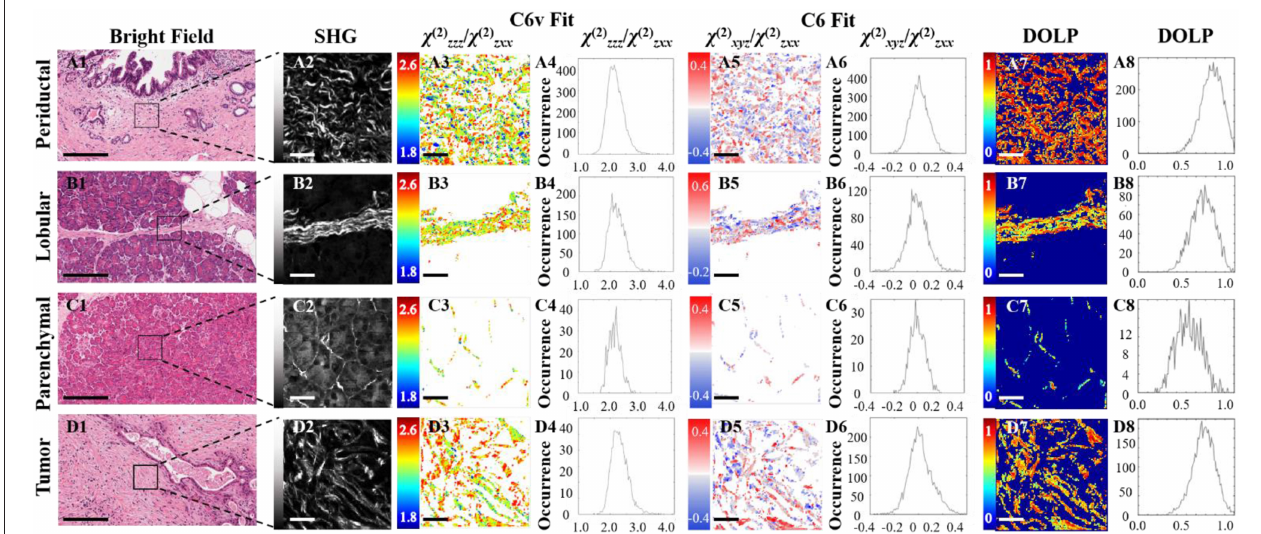
FIGURE 3 | PIPO SHG of collagen in normal periductal (A) , lobular (B) and parenchymal (C) pancreas tissues, and in pancreatic cancer (D) . Bright-field images (A1,B1,C1,D1) where the scale bar represents 200 µ m, and the corresponding SHG intensity images (A2,B2,C2,D2) of the regions of interest are shown, together with color-coded maps of the fitted R values (A3,B3,C3,D3) assuming C 6v symmetry and the occurrence histograms of the R values (A4,B4,C4,D4) where the scale bar represents 25 µ m. Color-coded maps of the fitted C values (A5, B5, C5, D5) and their occurrence histograms (A6,B6,C6,D6) assuming C 6 symmetry are also shown, along with maps of the extracted DOLP values (A7,B7,C7,D7) and occurrence histograms (A8,B8,C8,D8) where the scale bar represents 25 µ m.